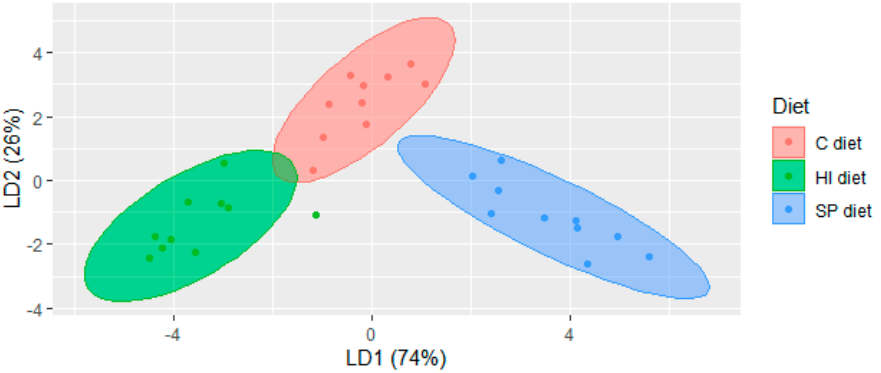
Figure 1. Linear Discriminant Analysis plot of the volatile compounds of chicken meat under three dietary treatments in Trial 1. C diet: Soybean meal- based diet; SP diet: Soybean meal-based diet partially supplemented with Arthrospira platensis ; HI diet: Soybean meal-based diet partially supplemented with Hermetia illucens larvae.